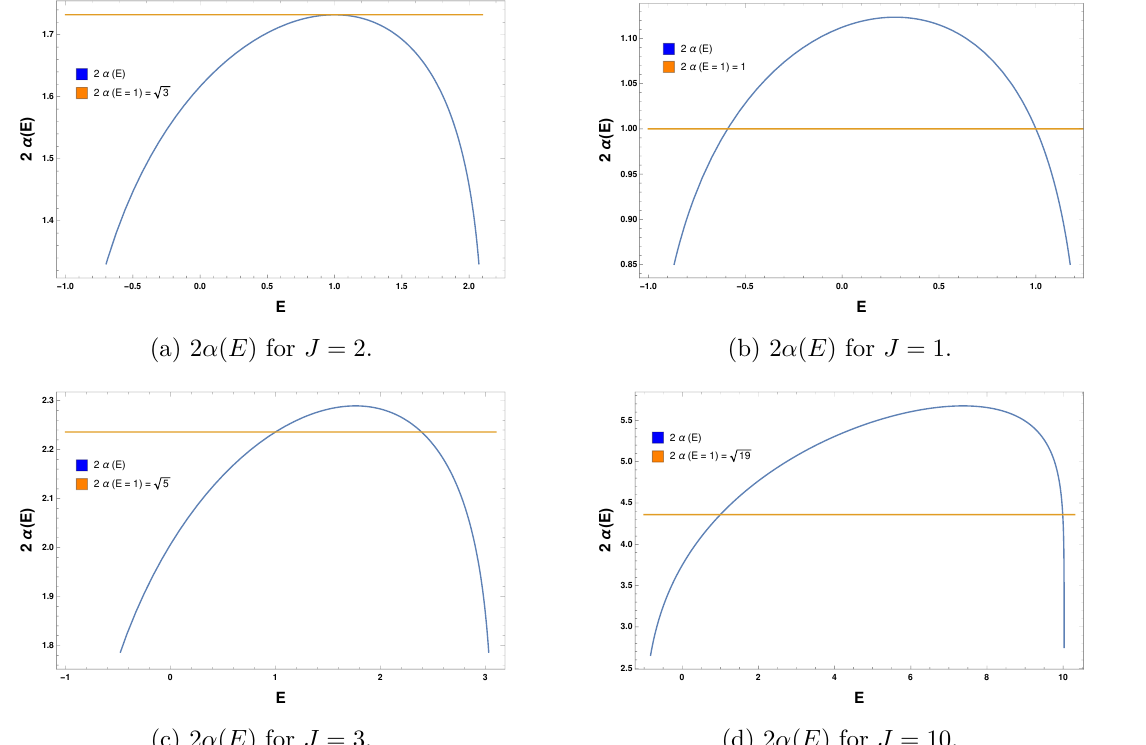
Figure 5. (a) Behavior of 2 α with respect to the energy E plotted for J = 2 (blue). The 2 α ( E = √ √ √ 2 J − 1 = 3 is given in orange. As is evident, the inequality sup 2 α ( E ) ≥ 2 J − 1 is E saddle ) = E saturated in this case. (b) Behavior of 2 α with respect to the energy E plotted for J = 1 (blue). √ The 2 α ( E = E ) = 2 J − 1 = 1 is given in orange. The inequality holds, and is not saturated. saddle (c) and (d) Behavior of 2 α with respect to the energy E plotted for J = 3 and 10 respectively √ √ √ (blue). The 2 α ( E = E ) = 2 J − 1 = 5 and 19 respectively, and are given in orange. The saddle inequality holds, and is not saturated. In fact, we can see that the difference between the two values increases with J . Note that this happens for J > 2 . For 1 / 2 < J < 2 , the difference decreases as J increases until it goes to 0 at J = 2